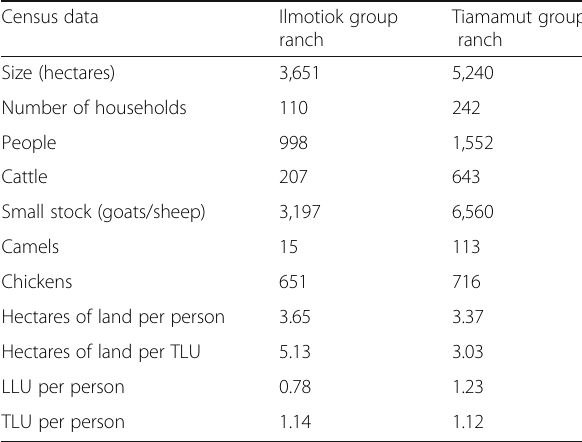
Table 2 Demographic characteristics of human and livestock populations in Ilmotiok and Tiamamut group ranches, Laikipia,